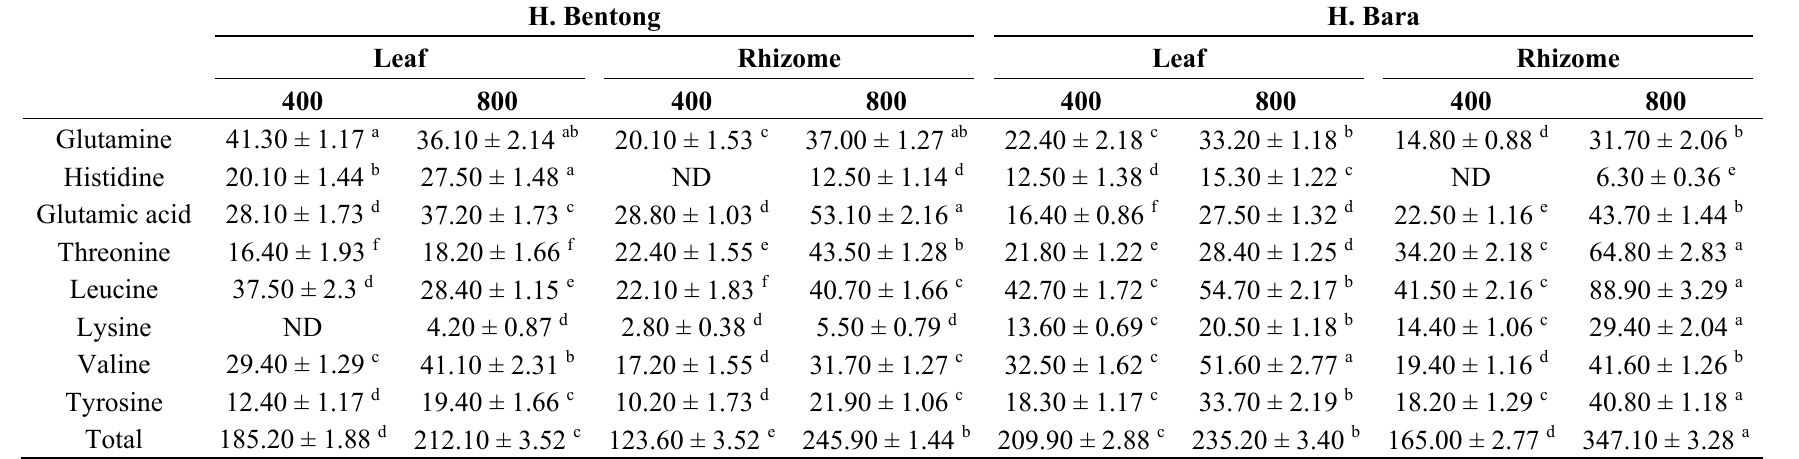
Table 3. Amino acids content in two variety of ginger grown under different CO 2 concentration (400 and 800 μ mol/mol).